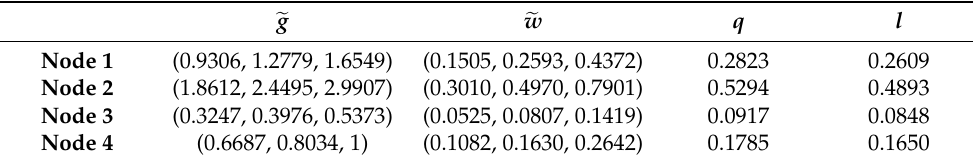
Table A9. Geometric mean ( (cid:101) g ) and weights ( (cid:101) w , q , l ) for No. neighbors criterion.